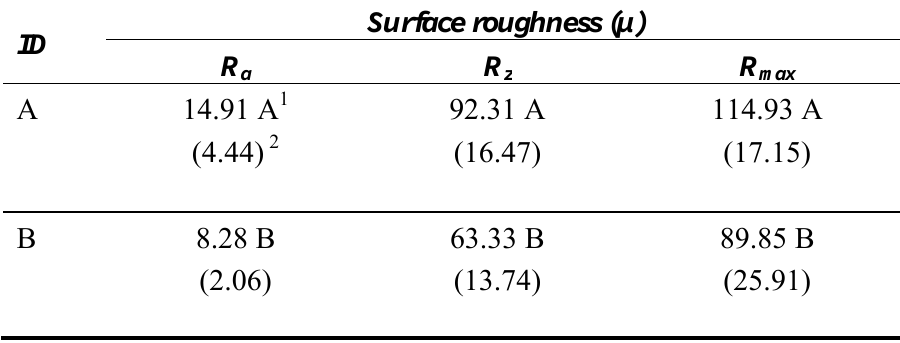
, R , R ) of HDPE a z max